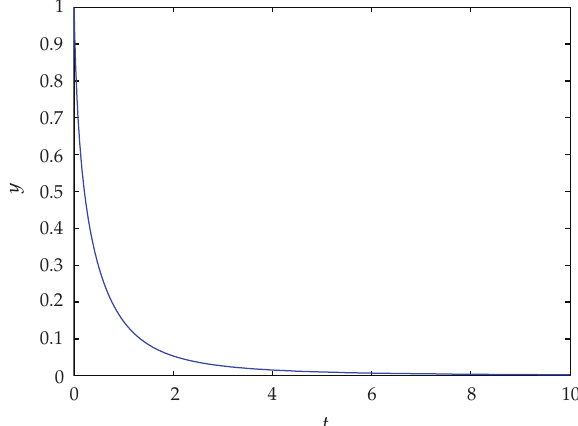
Figure 3: Numerical solution for the problem (cid:2) 1.1 (cid:3) described in (cid:2) 3.47 (cid:3)